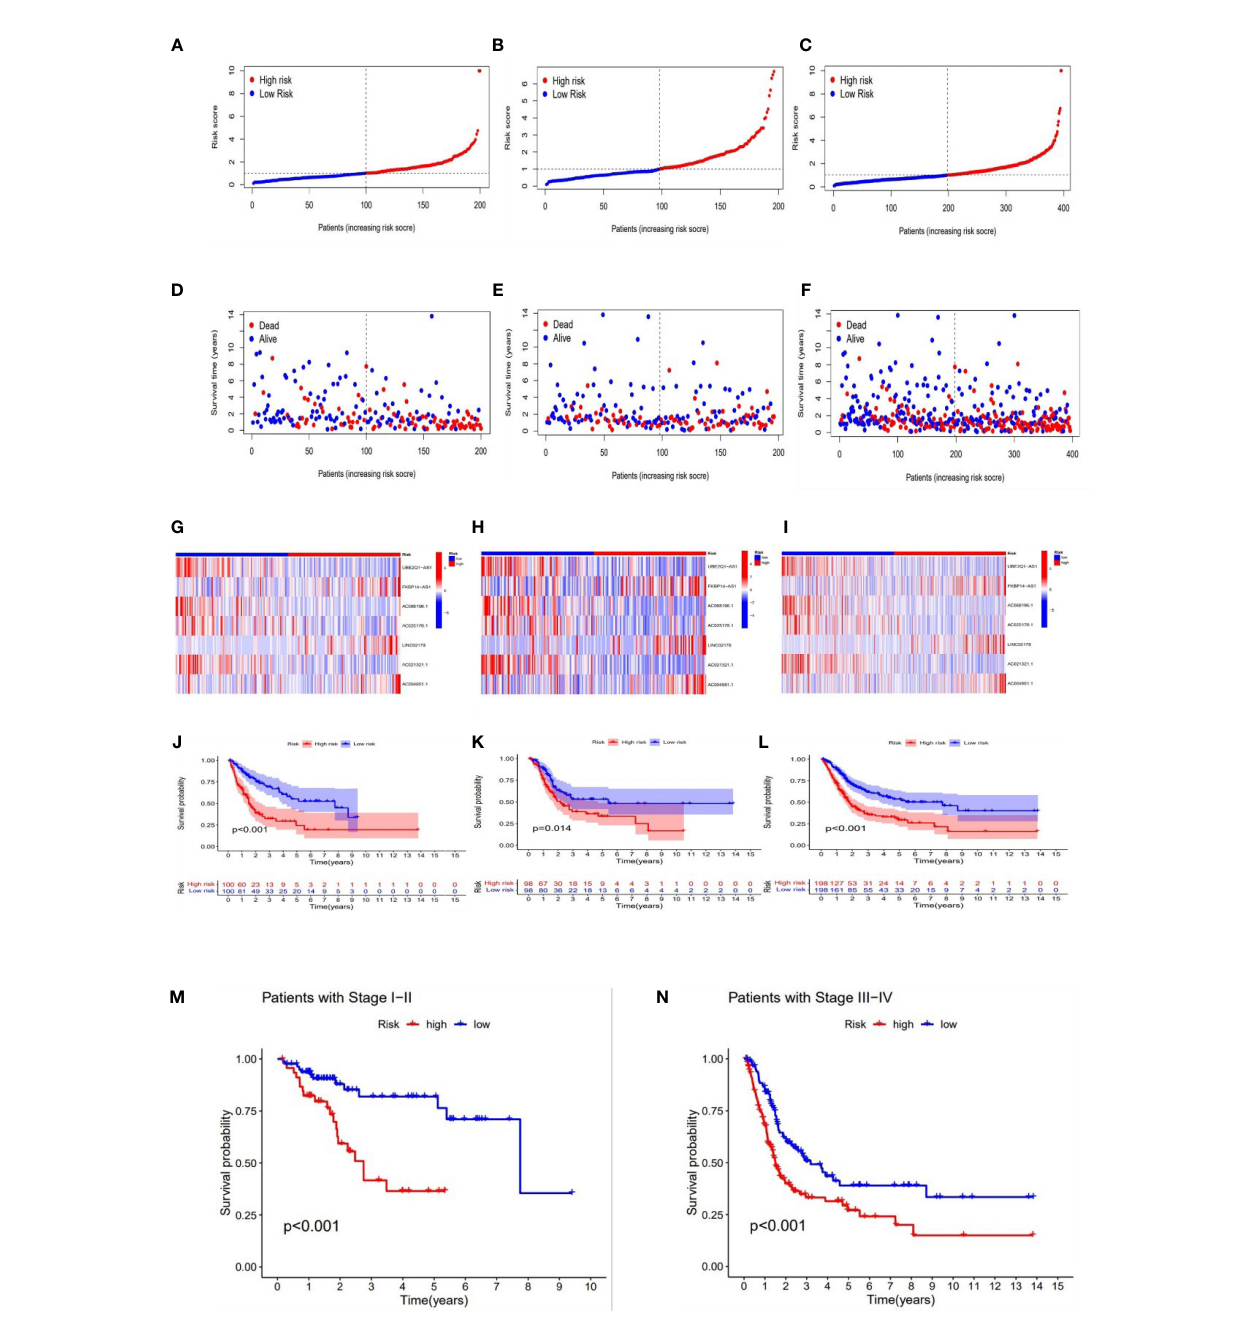
FIGURE 4 | Prognosis value of the 7 necroptosis-associated lncRNAs model in the train, test, and full groups, respectively. The distribution of risk scores (A – C) , survival time and survival status in the train, test, and full groups (D – F) . Heat maps of 7 lncRNA expression in the train, test, and full groups (G – I) . Kaplan – Meier survival curves of survival probability (OS) of patients in the train, test, and full groups (J – L) . Kaplan – Meier survival curves of survival probability (OS) prognostic value for the constructed model in the full groups with tumor stage (M – N)